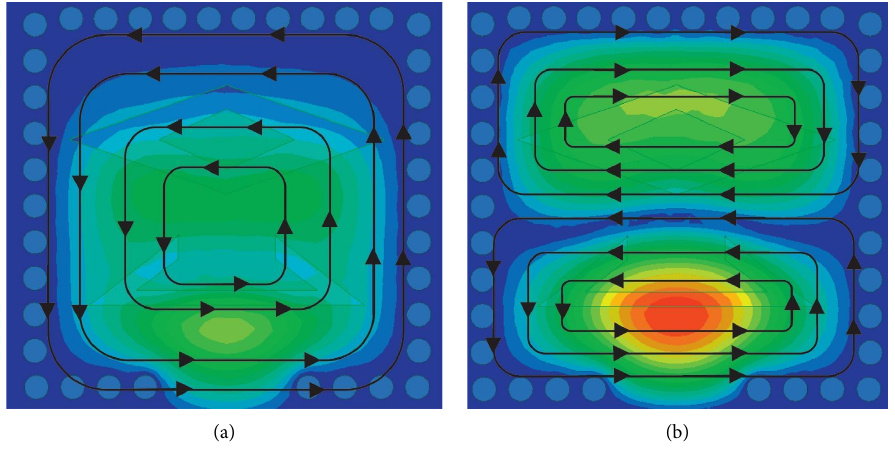
Figure 3: Distributions of the E-feld inside the cavity: (a) TE